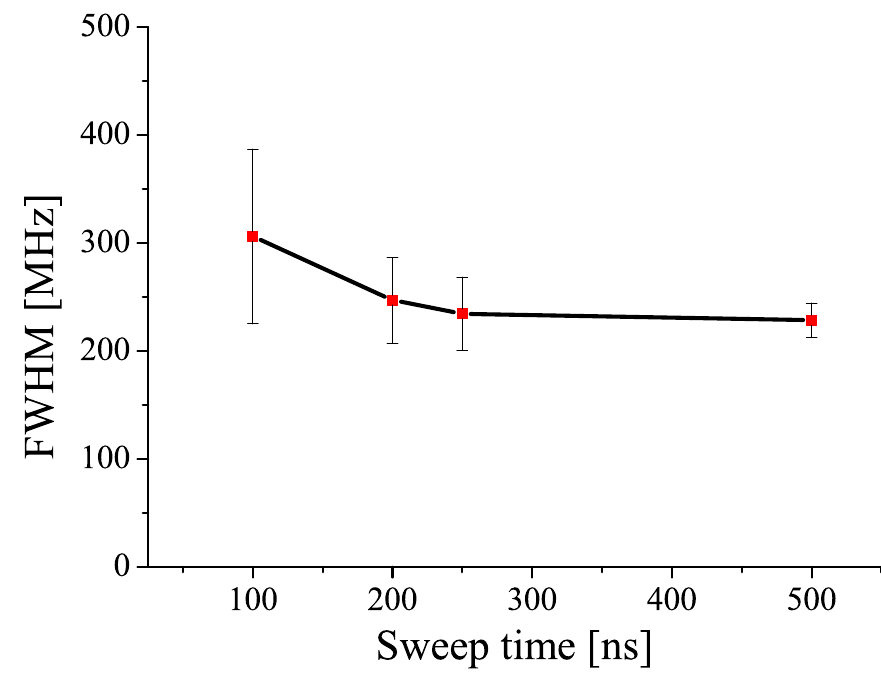
Figure 23. FWHMs of the passband for various sweep